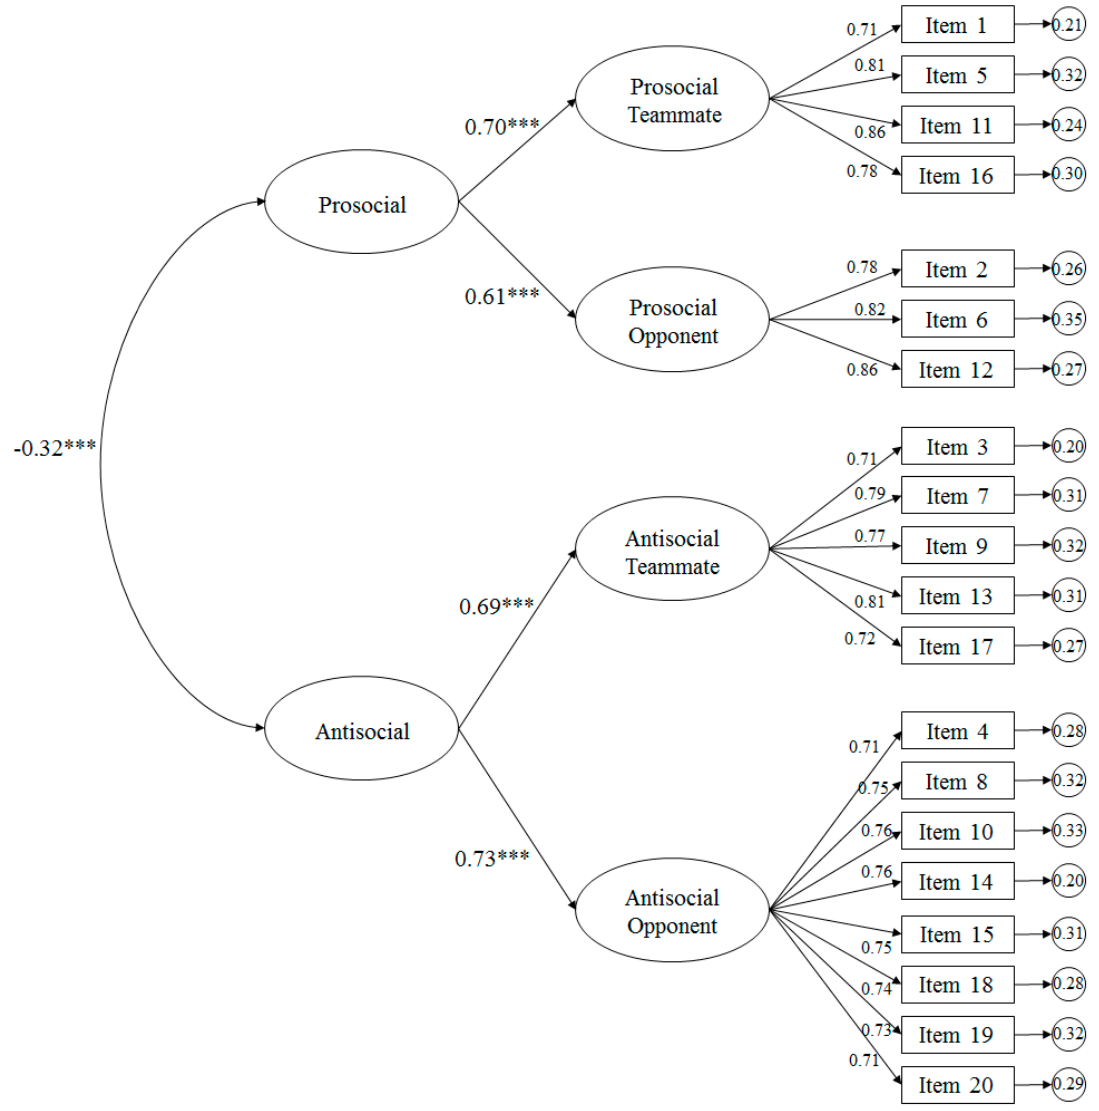
Figure 2. Diagram of the CFA belonging to the prosocial and antisocial scale in the context of the Physical Education. Note: *** p < 0.001.